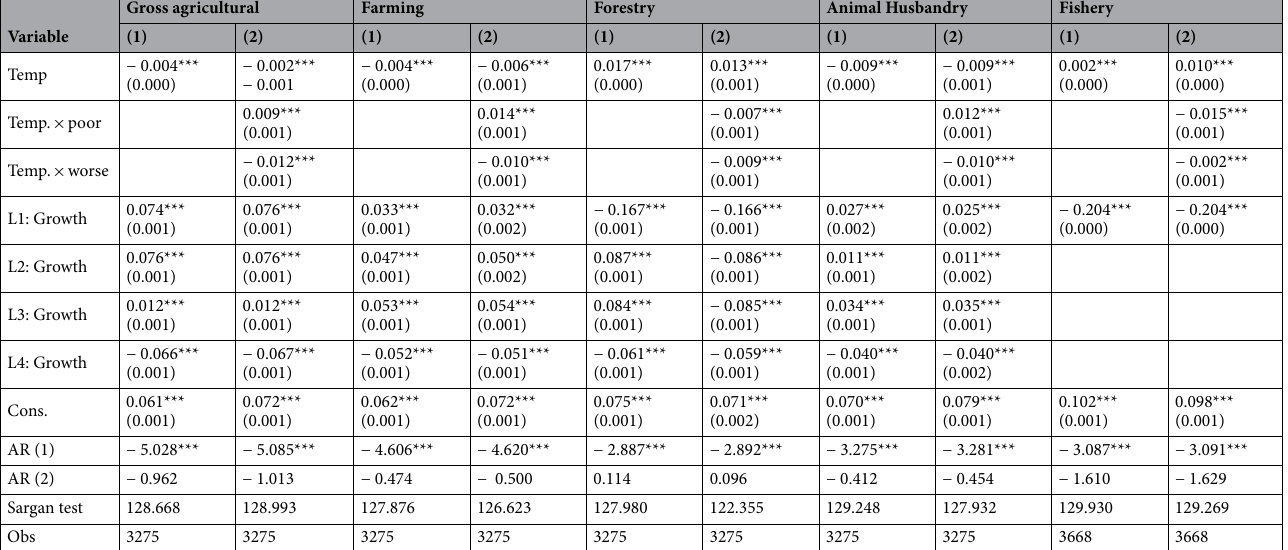
Table 7. Estimated impact of average temperature fluctuations on agricultural growth during the fallow period. (1) The values in parentheses are robust standard errors. (2) ***, **, * indicate significant at the statistical level of 1%, 5%, and 10%,